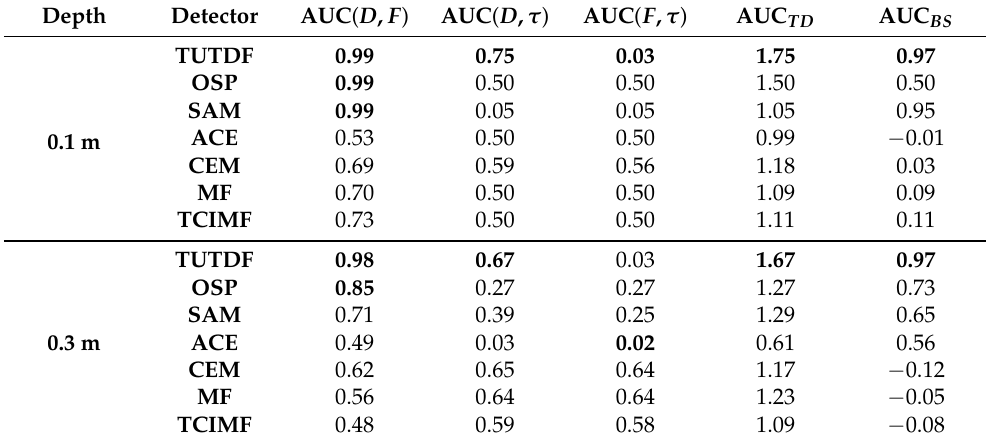
Figure 19. ( a ) Ground truth of the 0.1, 0.3, 0.6, 0.9 m submerged rubber plate. ( b ) TUTDF. ( c ) MF. ( d ) CEM. ( e ) ACE. ( f ) OSP. ( g ) SAM. ( h ) TCIMF. Table 6. AUC values calculated from the three 2D ROC curves of different detection results on RUBBER at various